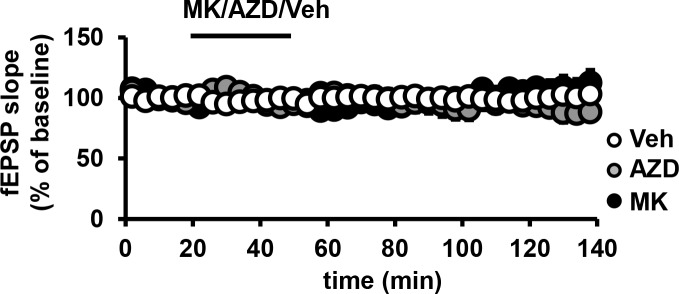
Effect of MK2206 or AZD5363 on basal fEPSPs in the hippocampus.Baseline recordings of field excitatory postsynaptic potentials (fEPSPs) in CA1 remain stable after incubation with MK2206 or AZD5363 (p>0.05), n= 9–11 slices/group, 4 mice/group respectively, (F(2,6)=120.3, p<0.0001), 3 mice/group.